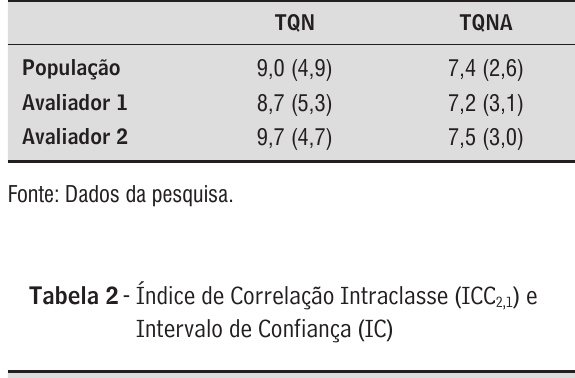
Tabela 2, juntamente com o ICC₂ , ₁ e IC do TQN e do